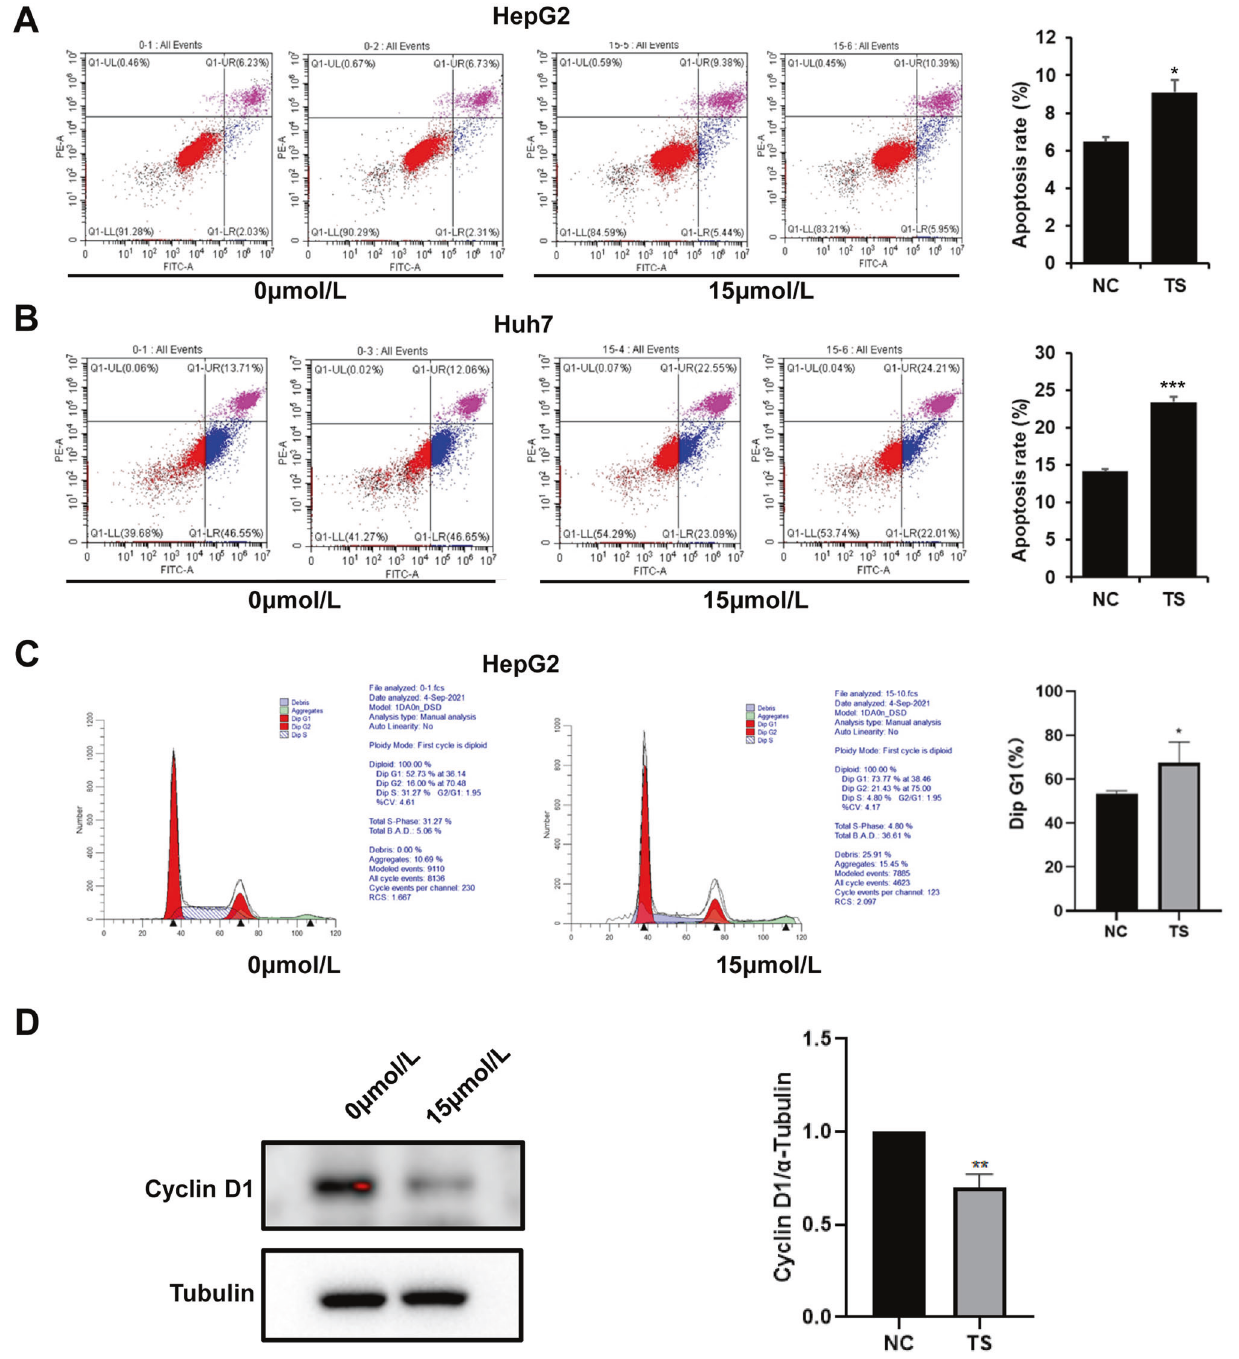
Fig. 2 TS induced apoptosis and blocked cell cycle of hepatoma cells in vitro. The effect of TS with 15 μ mol/L on apoptotic rate of HepG2 ( A ) and Huh7 ( B ) after 72 h using annexin V/PI double staining. C The effects of TS with 15 μ mol/L on the cell cycle of HepG2 through propidium iodide staining. D The expression of Cyclin D1 after treated with TS by WB assay and the statistical analysis. Results were obtained from experiments carried out in triplicate from at least three independent experiments. Data are presented as the mean ± SD ( n = 5). * p < 0.05 vs. the Control group; ** p < 0.01 vs. the Control group; *** p < 0.001 vs. the Control using WB. The results showed that the translation of both oncogene STAT3 and its upstream gene IL-6 were downregulated after TS treatment (Fig. 5A, B). Additionally, the apoptotic protein marker Bcl-2 was inhibited while cleaved caspase-3 was increased (Fig. 5C, D). These results indicated that TS affected the expression of apoptosis related proteins and IL-6/STAT3 pathway related proteins in HCC related cell lines.